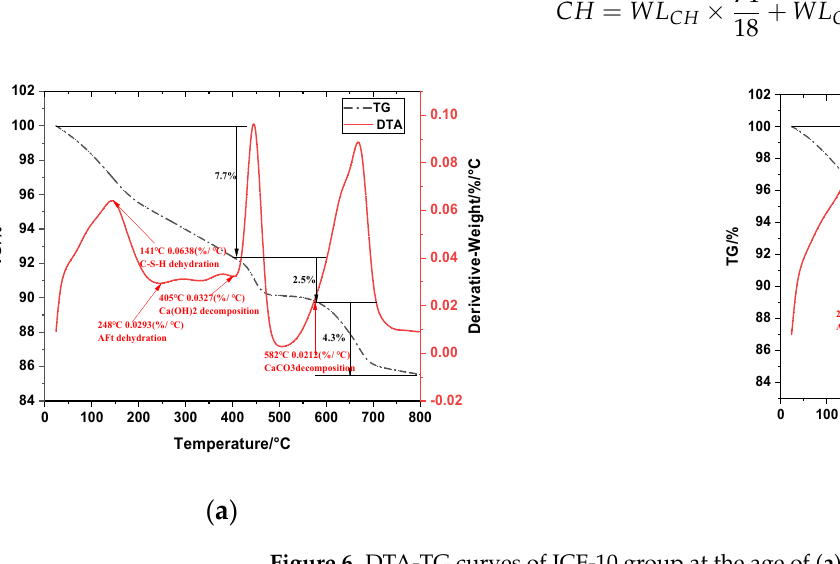
Figure 6. DTA-TG curves of ICF-10 group at the age of ( a ) 7 d and ( b ) 28 d.